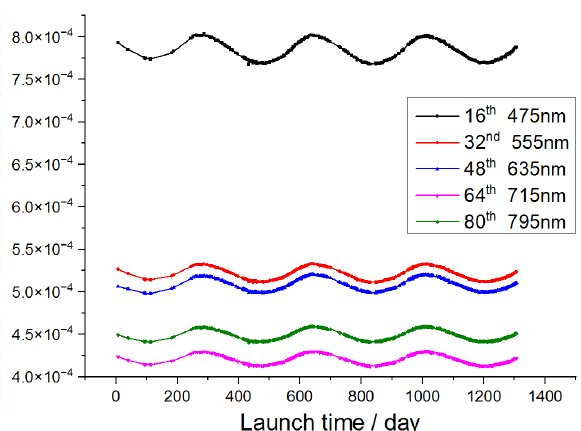
Figure 5. Long-term onboard calibration coefficients of the 16th, 32nd, 48th, 64th and 80th spectral bands of SCS.